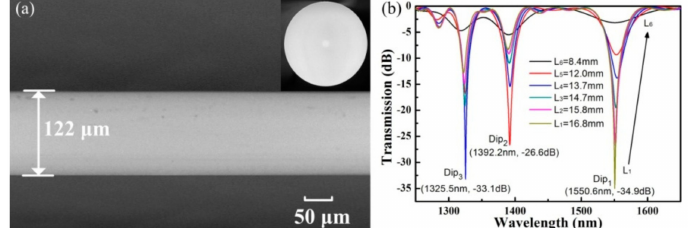
Figure 12. ( a ) Scanning electron micrographs and ( b ) transmission spectrum evolution of the HLPFG in SMF while the length decreases [13].